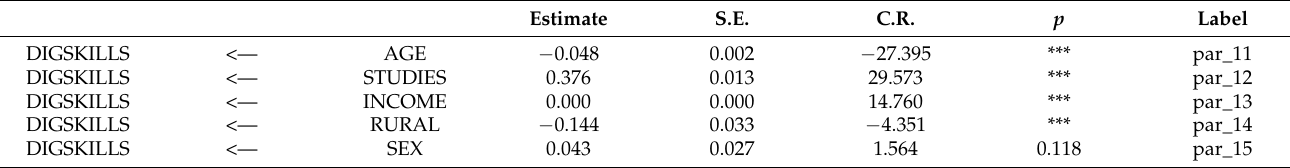
Table A10. Regression Weights: (Group number 1-Default